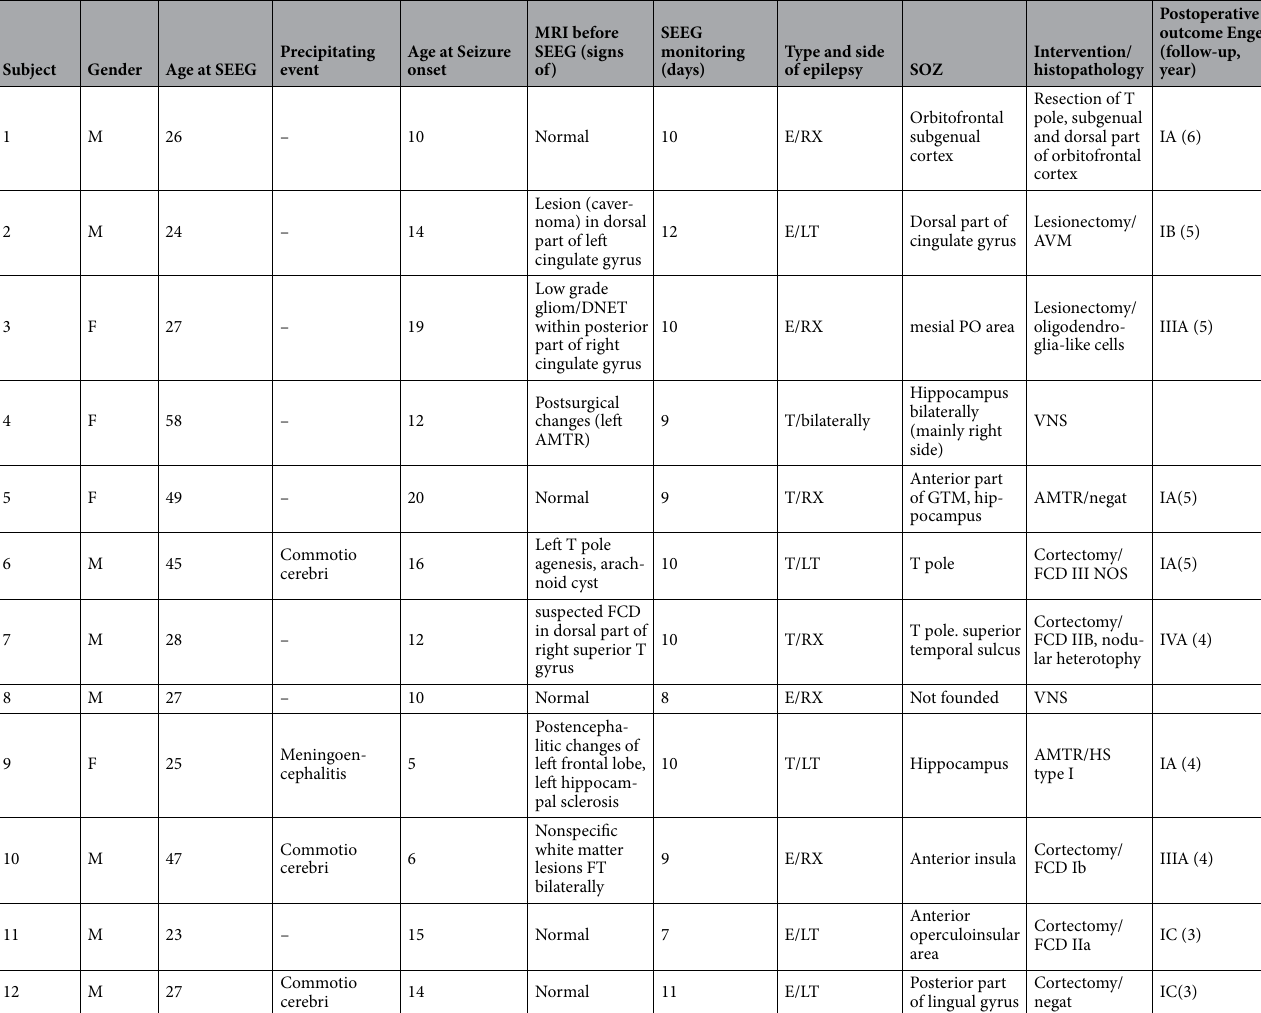
Table 1. Clinical description of 12 patients from St. Anne’s University Hospital that were used for pseudo- prospective testing. M male, F female; SEEG stereoelectroencephalography; E extratemporal; T temporal; PO parieto-occipital; FT fronto-temporal; RX / LT right/left; GTM medial temporal gyrus; SOZ seizure onset zone; AMTR anteromedial temporal resection; DNET dysembryoplastic neuroepithelial tumor; AVM arteriovenous malformation; FCD focal cortical dysplasia; HS hippocampal sclerosis; VNS vagus nerve